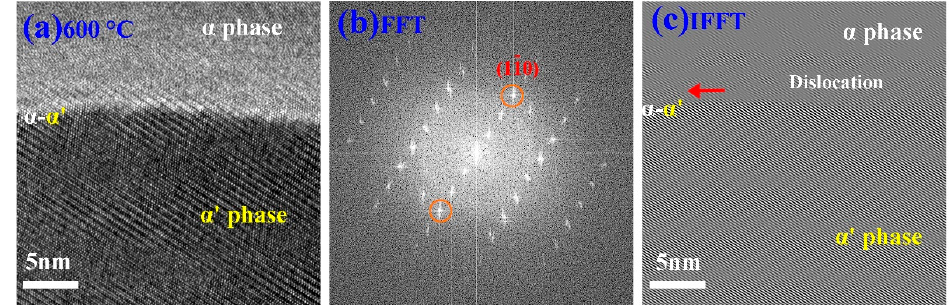
Figure 8. ( a ) A square section of HRTEM image from Figure 7f; ( b ) The fast Fourier transform (FFT) pa tt ern of ( a ); ( c ): The inverse fast Fourier transform (FFT) image with marked all the